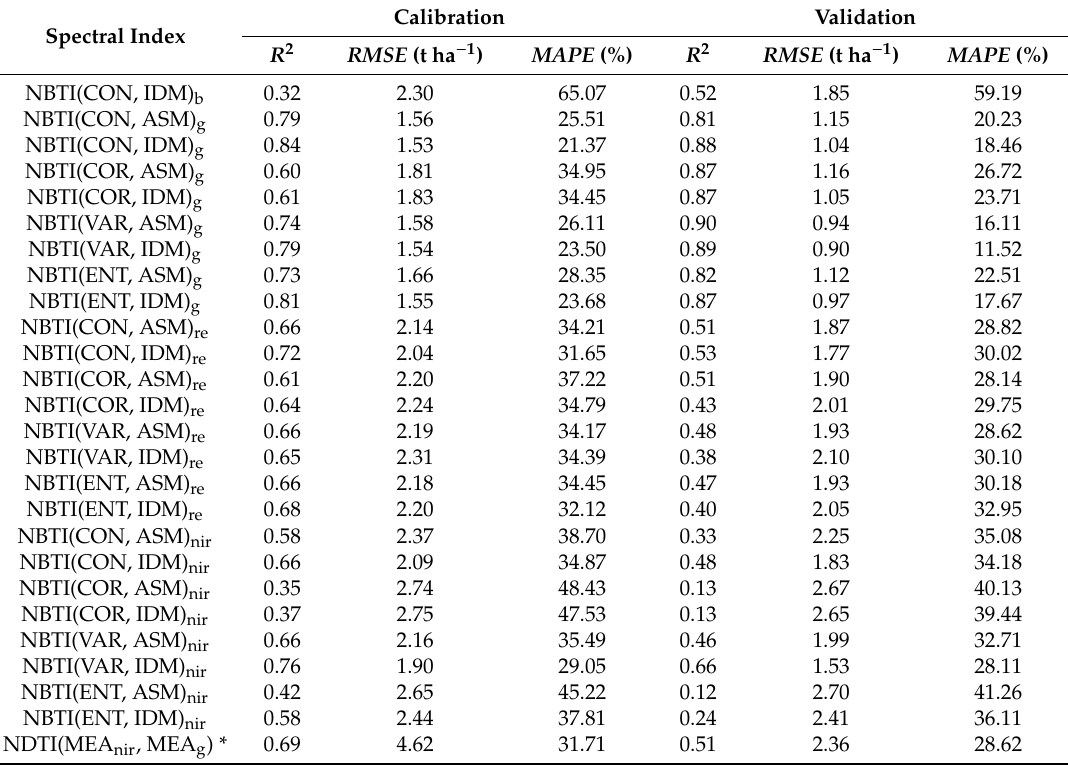
Table 5. Calibration and validation results for the cotton biomass estimation models designed using textural indices. During model calibration, linear, logarithm, exponential, and power models were used to design model, with the best results shown